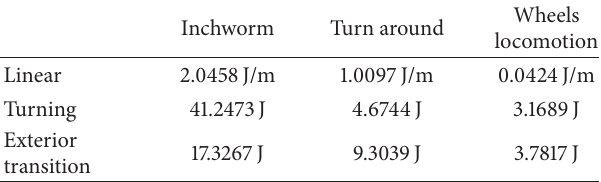
Figure 15: The joints’ torque profiles for the inchworm gait. Table 3: The total energy demand of different